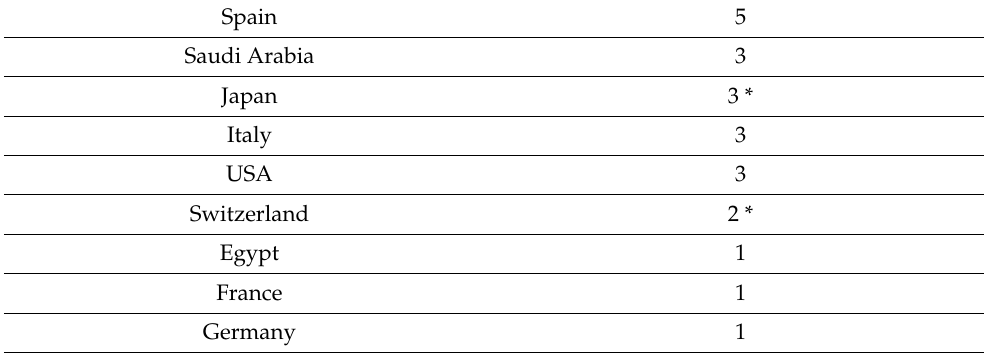
Table 1. Country representation of the included studies (N = 21).